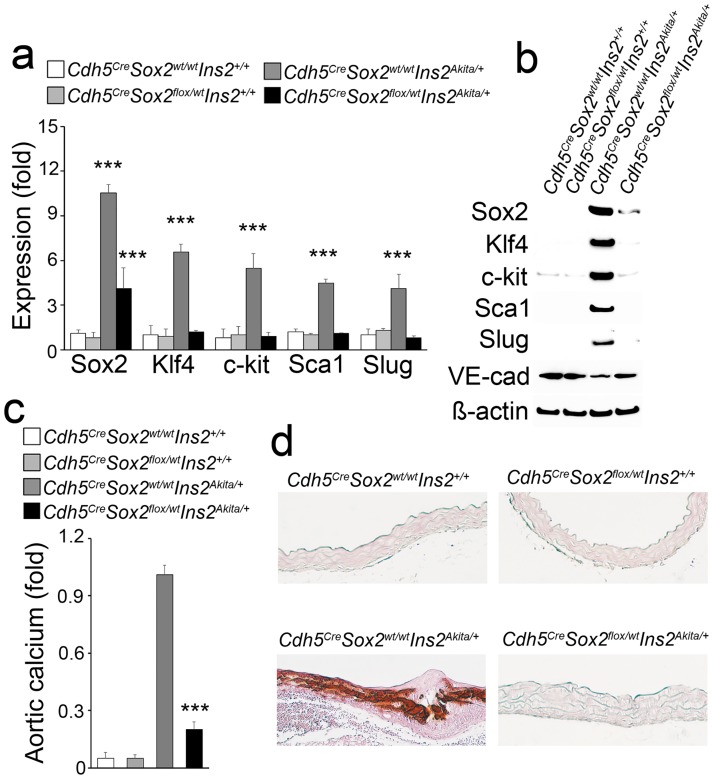
Limiting Sox2 in endothelium decreases EndMTs and calcification in Ins2Akita/+ aortas.(a-b) Decreased expression of Sox2, stem cell and mesenchymal markers in aortas of Cdh5CreSox2Flox/wtIns2Akita/+, as shown by real-time PCR (a) and immunoblotting (b). VE-cad:VE-cadherin. (c-d) Total aortic calcium and aortic Alizarin red staining of Cdh5CreSox2wt/wtIns2+/+ and Cdh5CreSox2Flox/wtIns2+/+, Cdh5CreSox2wt/wtIns2Akita/+ and Cdh5CreSox2Flox/wtIns2Akita/+ mice. ***p<0.001.